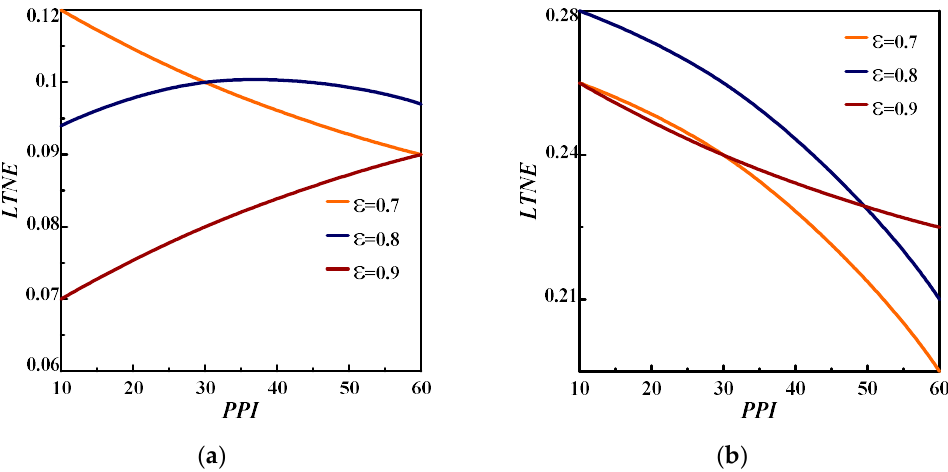
Figure 7. Pore density effect on LTNE criteria for Re = 400 during: ( a ) charging case; ( b ) discharging